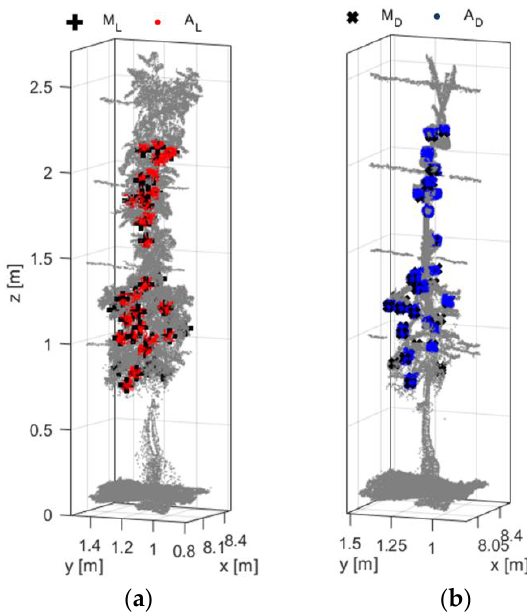
Figure 8. Representation of ( a ) detected centers in foliated trees (M L ) and ( b ) after defoliation (M D ). The red color depicts the apple points of the foliated tree (A L ) while the blue color show the points of the fruits in the defoliated tree (A D ).